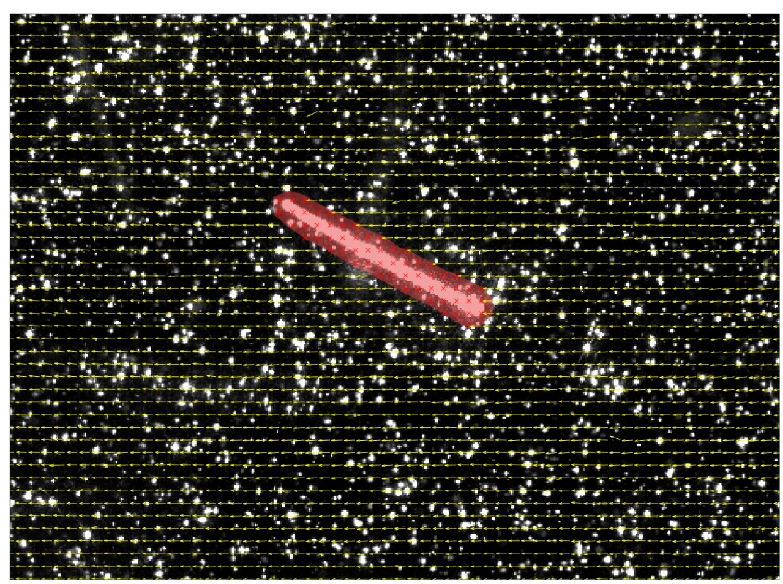
Figure 3. Instantaneous vector field surrounding a fiber (enlarged region) overlaid onto the original acquired image. Highlighted in red is the calculated fiber mask. C low and k 1 case.